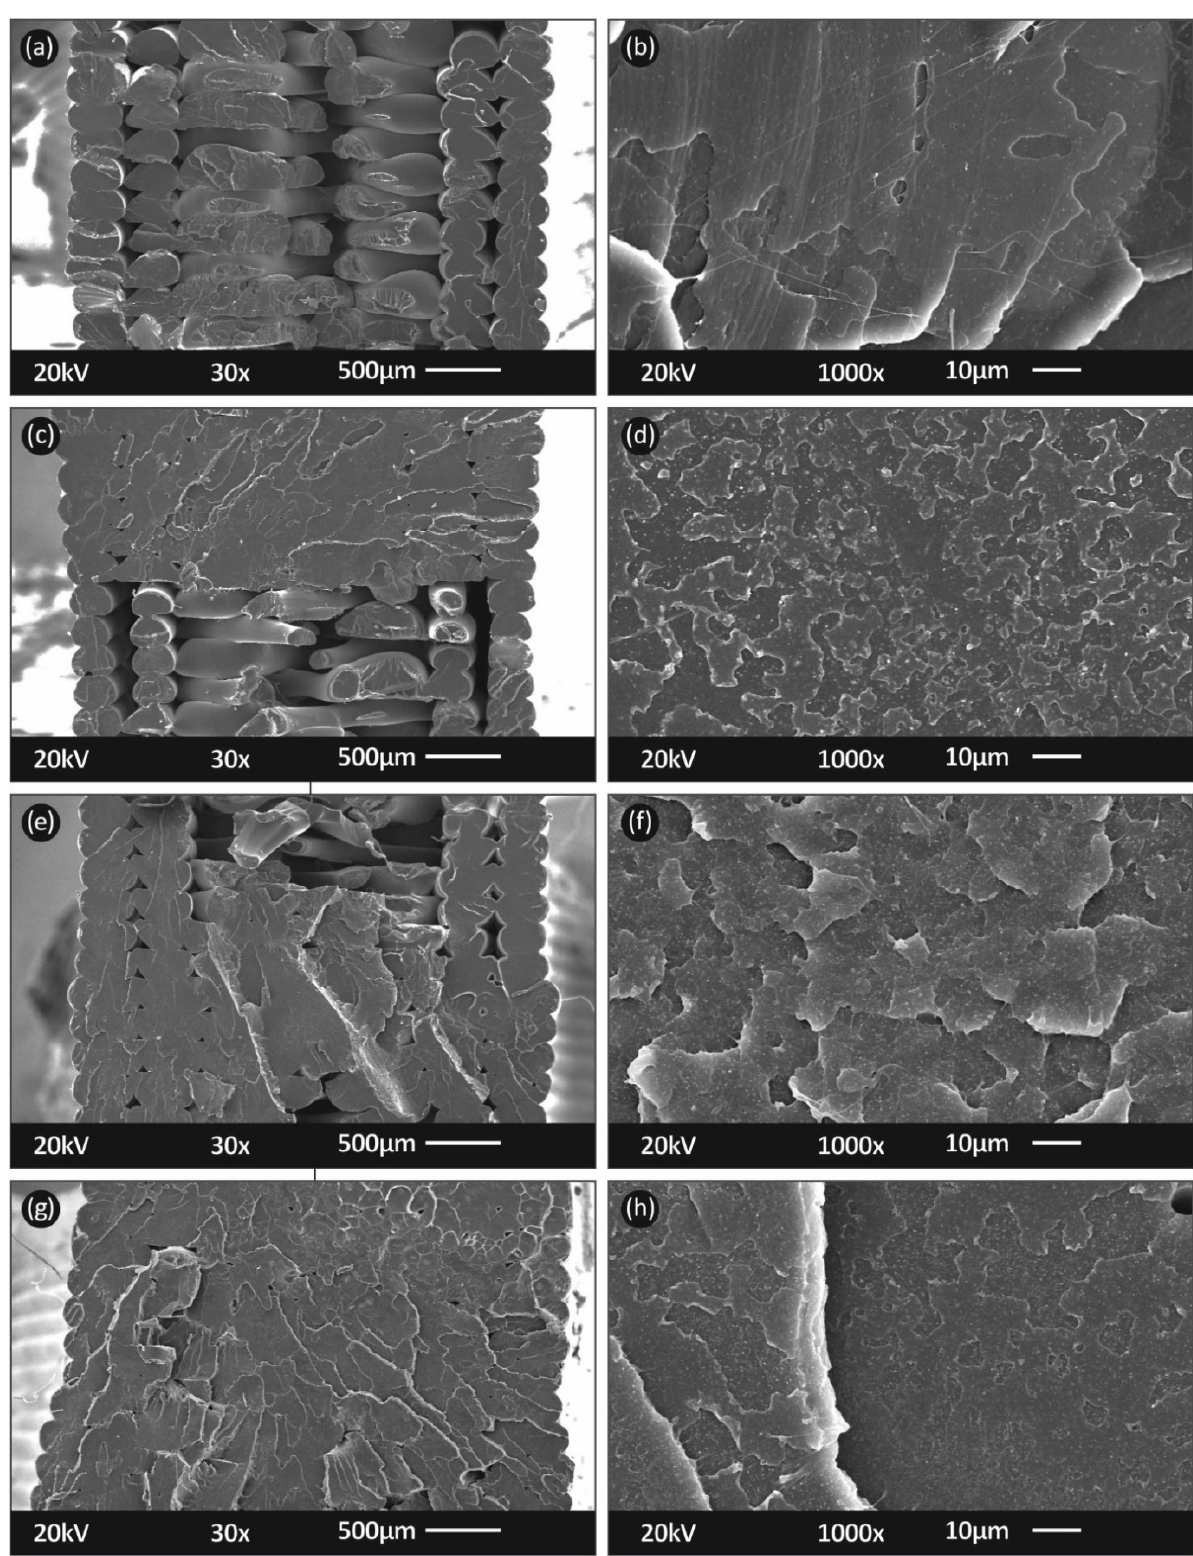
Figure 8. Fractured surface morphology of PLA/CB 3D printed nanocomposites after tensile tests: neat PLA ( a , b ) compared to 2.5 wt.% ( c , d ), 5.0 wt.% ( e , f ) and 10.0 wt.% ( g , h ) CB filler loading, respectively.